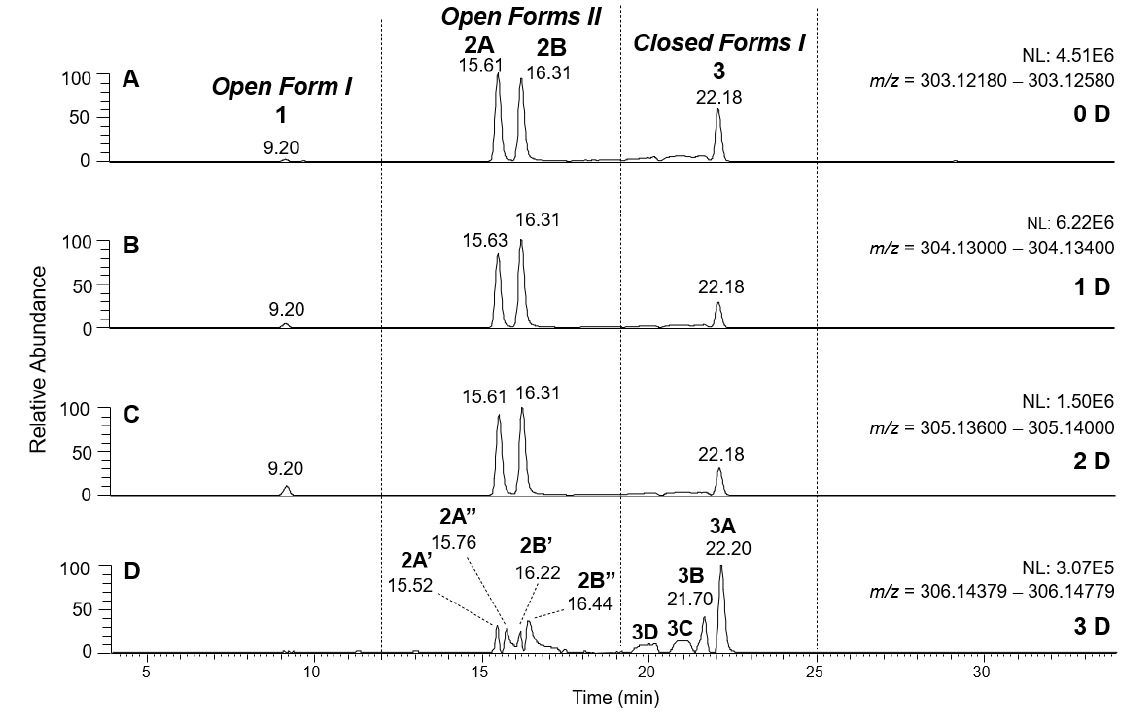
Figure 5. Comparison between XIC chromatograms obtained for the anions of non ‐ deuterated (0 D, panel A) and mono ‐ (1 D, panel B), bis ‐ (2 D, panel C) and tris ‐ (3 D, panel D) deuterated isoforms of OLEO, resulting from the HDX occurring during the RPLC ‐ ESI( ‐ ) ‐ FTMS analysis of an EVOO polar extract using D 2 O as co ‐ solvent of acetonitrile in the mobile phase. The m / z intervals adopted for the extraction of ion currents are reported along with the normalization levels (NL). The proposed structure for each isoform is depicted in Table 1